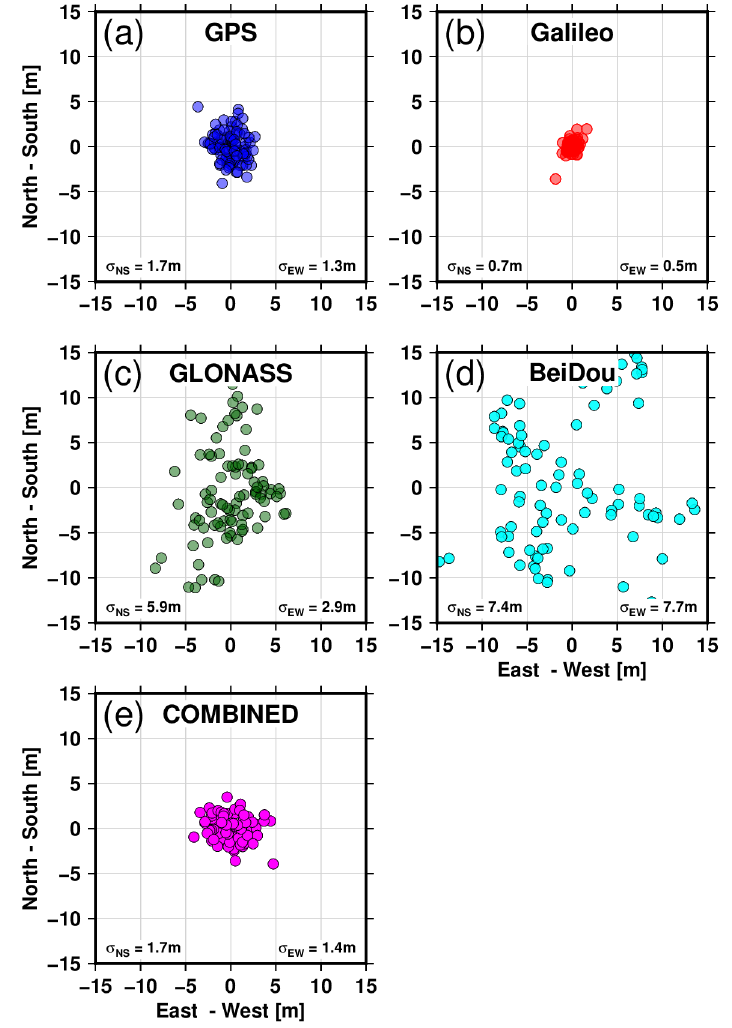
Figure 11. Single-point positioning for site KBG1 with Eccosorb absorbing material surrounding its antenna using multi-GNSS observables. Results are shown in blue for GPS ( a ), in red for Galileo ( b ), in dark green for GLONASS ( c ) and cyan for BeiDou ( d ), and in the magenta for COMBINED ( e ). The positioning accuracy using GPS in the north-south direction is 1.7m, and in the east-west direction, it is 1.3m; for Galileo, it is 0.7m and 0.5m, respectively, highlighting the added value of Galileo; for GLONASS, it is 5.9m and 4.0m; and the lowest accuracy comes from BeiDou, with 7.4m and 7.7m. We have also derived a combined GPS + GLONASS + Galileo + BeiDou solution with a north-south direction accuracy of 1.7m and east-west accuracy of